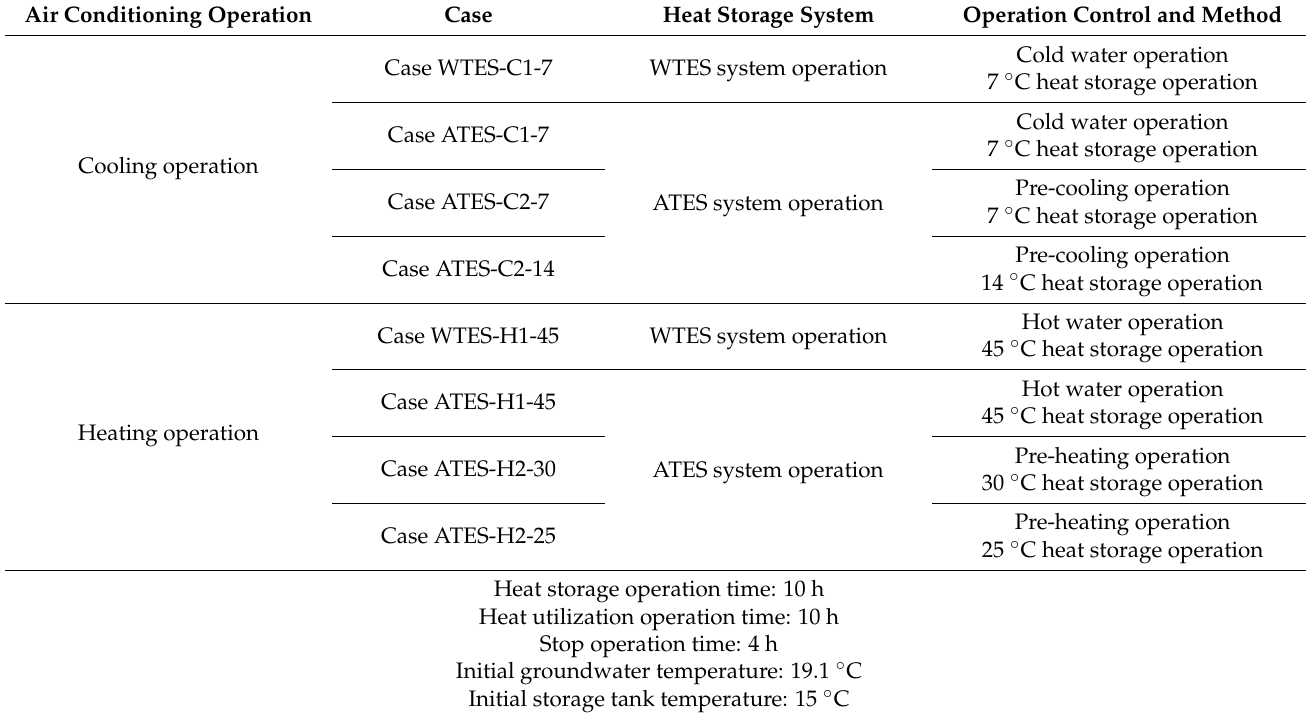
Table 4. Cooling and heating operation